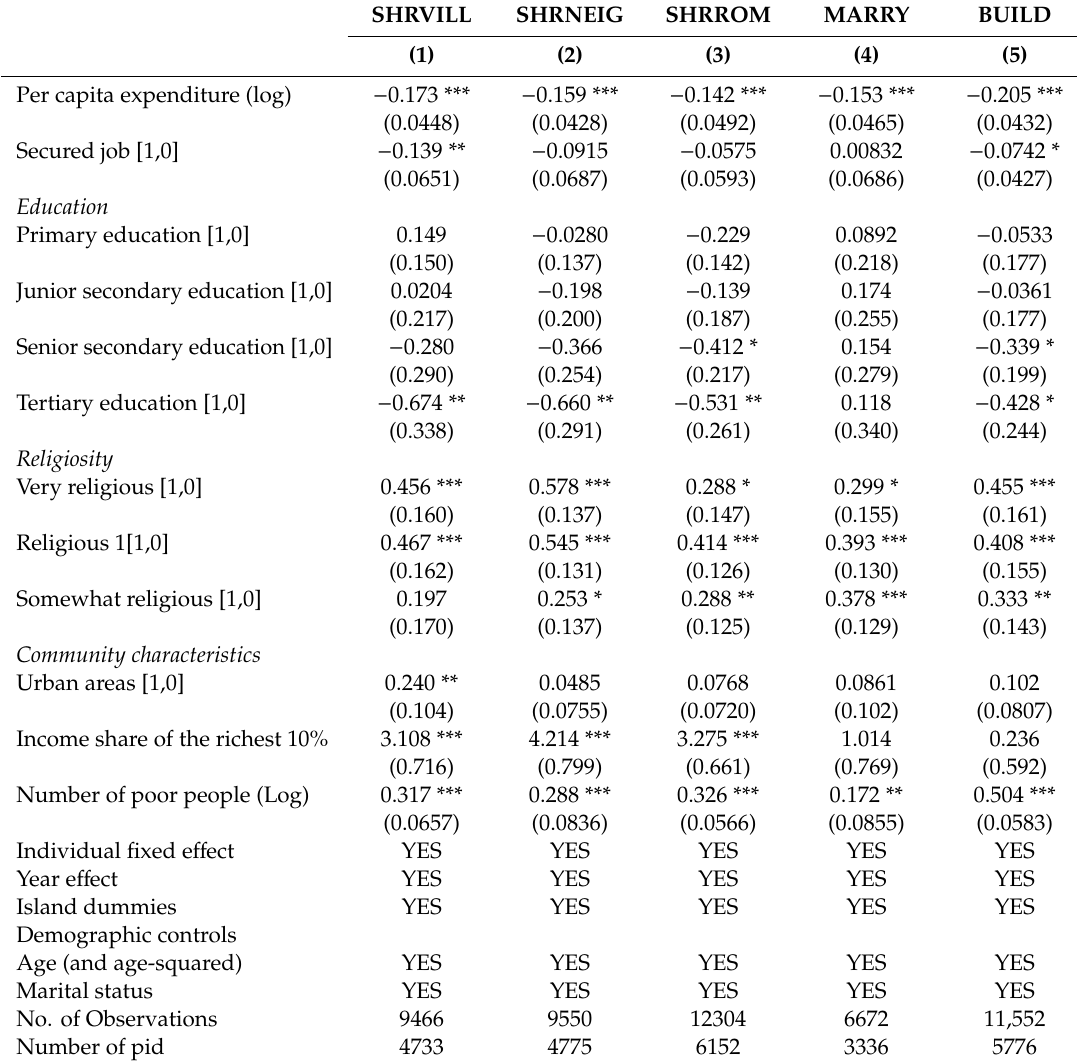
Table A4. Regression results (Fixed-e ff ect conditional logit Model), Richest 10%. SHRVILL SHRNEIG